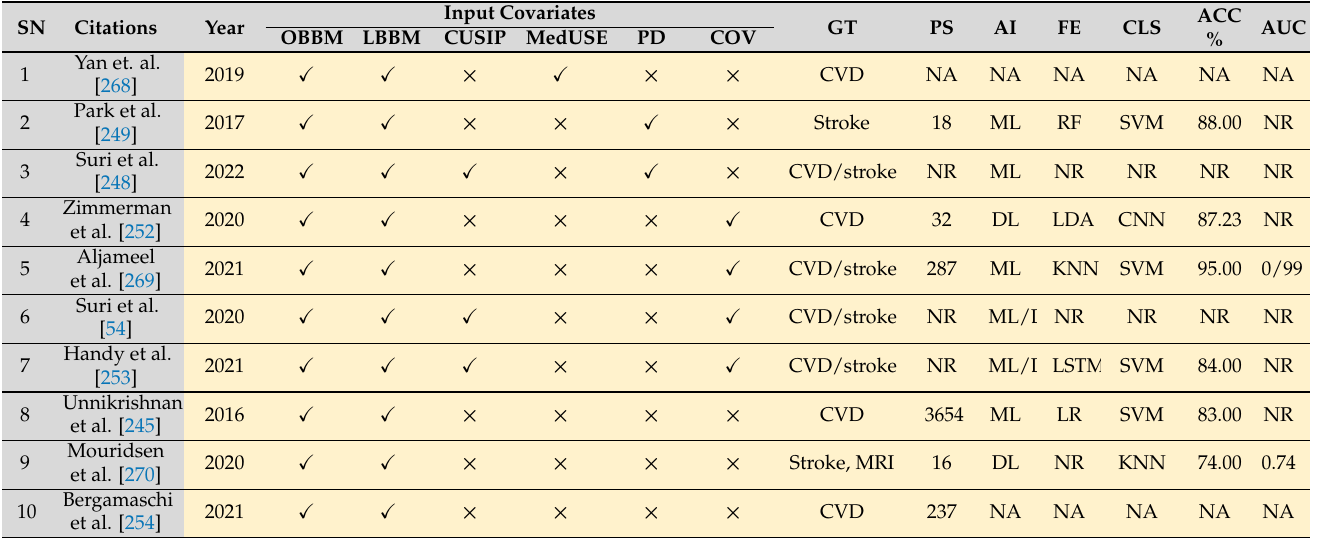
Table 6. Comparative analysis of AI-based studies with CVD/stroke risk stratification of PD patients in the COVID-19